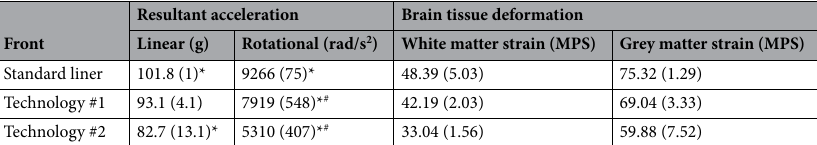
Table 1. Summary table with means of impact variables measured with the standard deviations in brackets for the front location. *Indicates significant difference (alpha level p < 0.05), when the two technologies are compared to the standard liner. # Indicates significant difference (alpha level p < 0.05), when the two technologies are compared to each other.